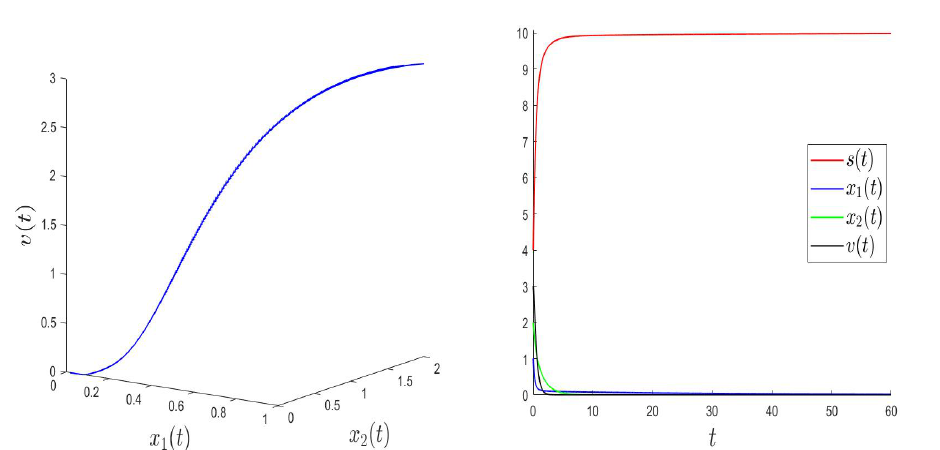
Figure 7. D = 2.525, D 1 = 2.5, D 2 = 1.875, D 4 = 1.89375, D 5 = 1.96, ¯ s 1 = 10.2712, ¯ s = 11.3066. Assumption 1 is not satisfied, and the solution of the system (2) converges to the equilibrium E , where the two species goes